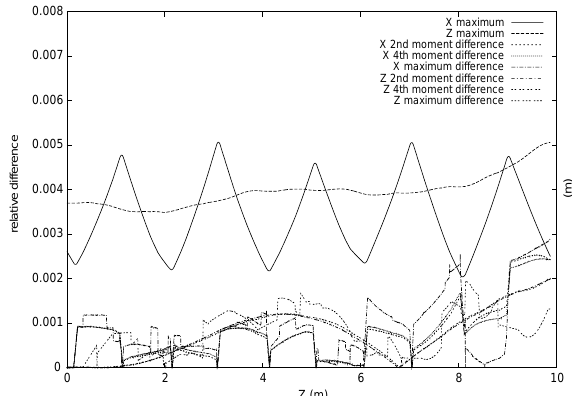
FIG. 8. (a) The maximum particle amplitude, (b) relative mo- ment difference as a function of position with larger initial lon- gitudinal emittance than the reference case.